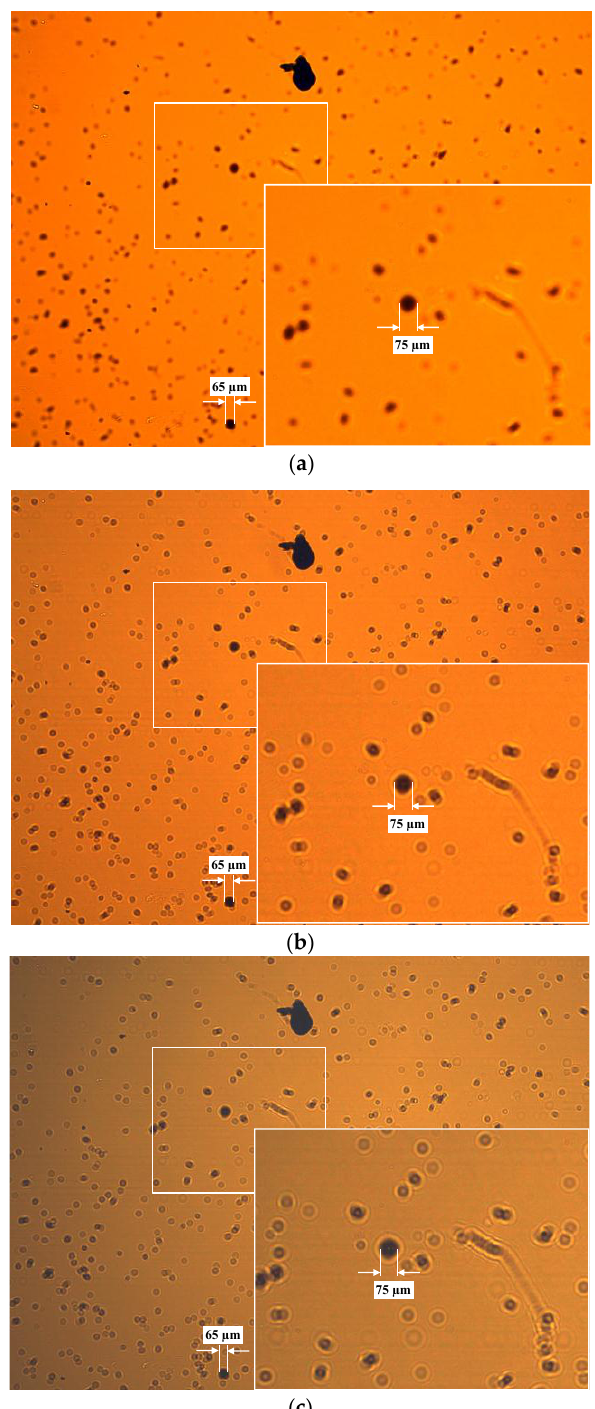
Figure 12. Examples of results with the lens-less test bench. Full FOV and Detailed view of a contaminated fluid sample with ( a ) D pinhole = 500 μm; ( b ) D pinhole = 200 μm; and ( c ) D pinhole = 50 μm all of them with Z 1 = 11 mm and Z 2 = 1 mm. Light Power and T ON pulses have been configured for achieving similar image intensity on all configurations.